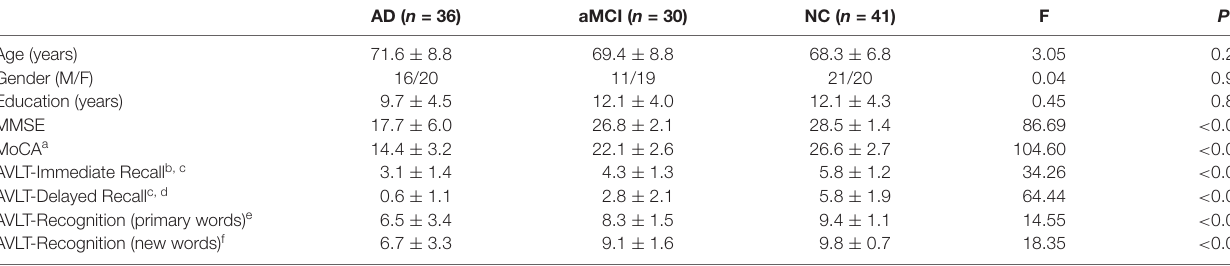
TABLE 1 | Demographic and neuropsychological data in the AD, aMCI, and NC